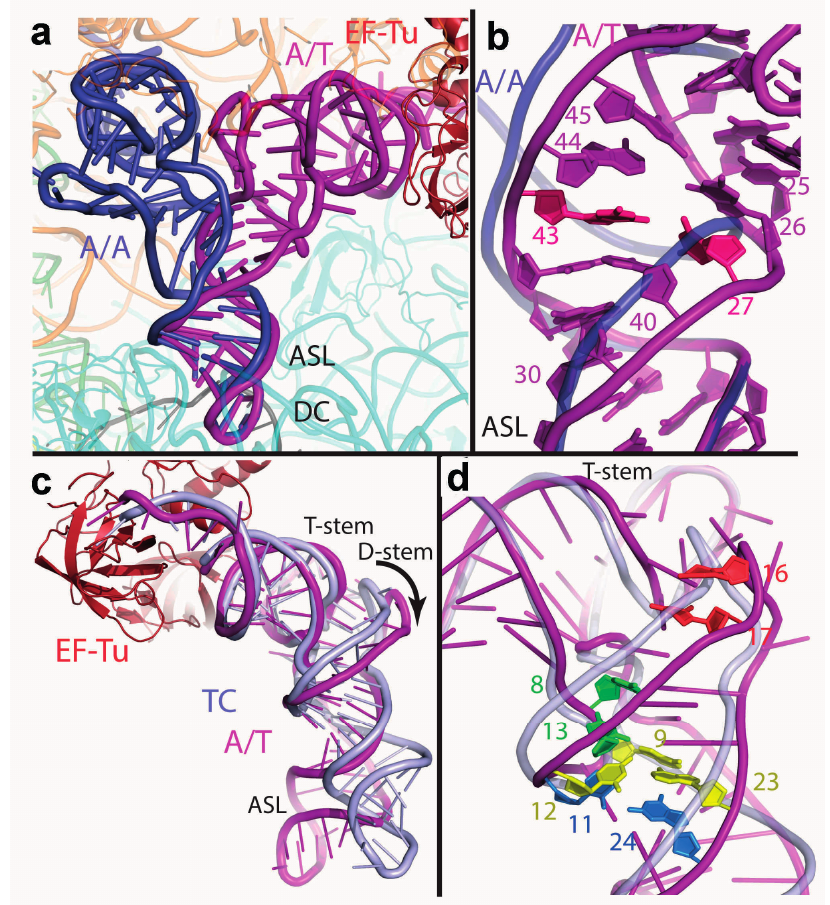
Figure 4. The A/T state of tRNA binding. ( a ) Comparison of the A/T tRNA (PDB 4V5G [129]) with the A/A tRNA that mimics the accommodated state (PDB 4V5D [133]); ( b ) Major changes are observed in the ASL region, as the helical twist is reduced after base pair 30:40. Also, the helical strands split at nucleotides 25 to 45 and 26 to 44. The well-known 27:43 base pair mutation (highlighted in pink) results in an error-prone phenotype [134], as it probably weakens the ASL stem and thus, facilitates the strand separation that leads to the final distorted form of the incoming tRNA; ( c ) Comparison of the A/T tRNA (PDB 4V5G [129]) with the EF-Tu bound form (TC) in the absence of the ribosome (PDB 1TTT [11]); ( d ) A gallery of mutations/manipulations in the tRNA molecule that affect the accuracy of decoding are highlighted: Cross-linking of nucleotides 8 and 13 [135], and mutations at 9:12:23 [136] and 24:11 [136–138]. Note that contrary to previous assumptions, subsequent structural analysis by Schmeing and coworkers [130] discarded the idea that the so-called Hirsh mutation influences the flexibility/deformability of the tRNA. This framework also puts into context previous kinetic experiments: see proflavin insertions at positions 16 and 17, e.g., see [20]. (Figure adapted from [129], Copyright 2009 Am. Assoc. Adv. Sci.)